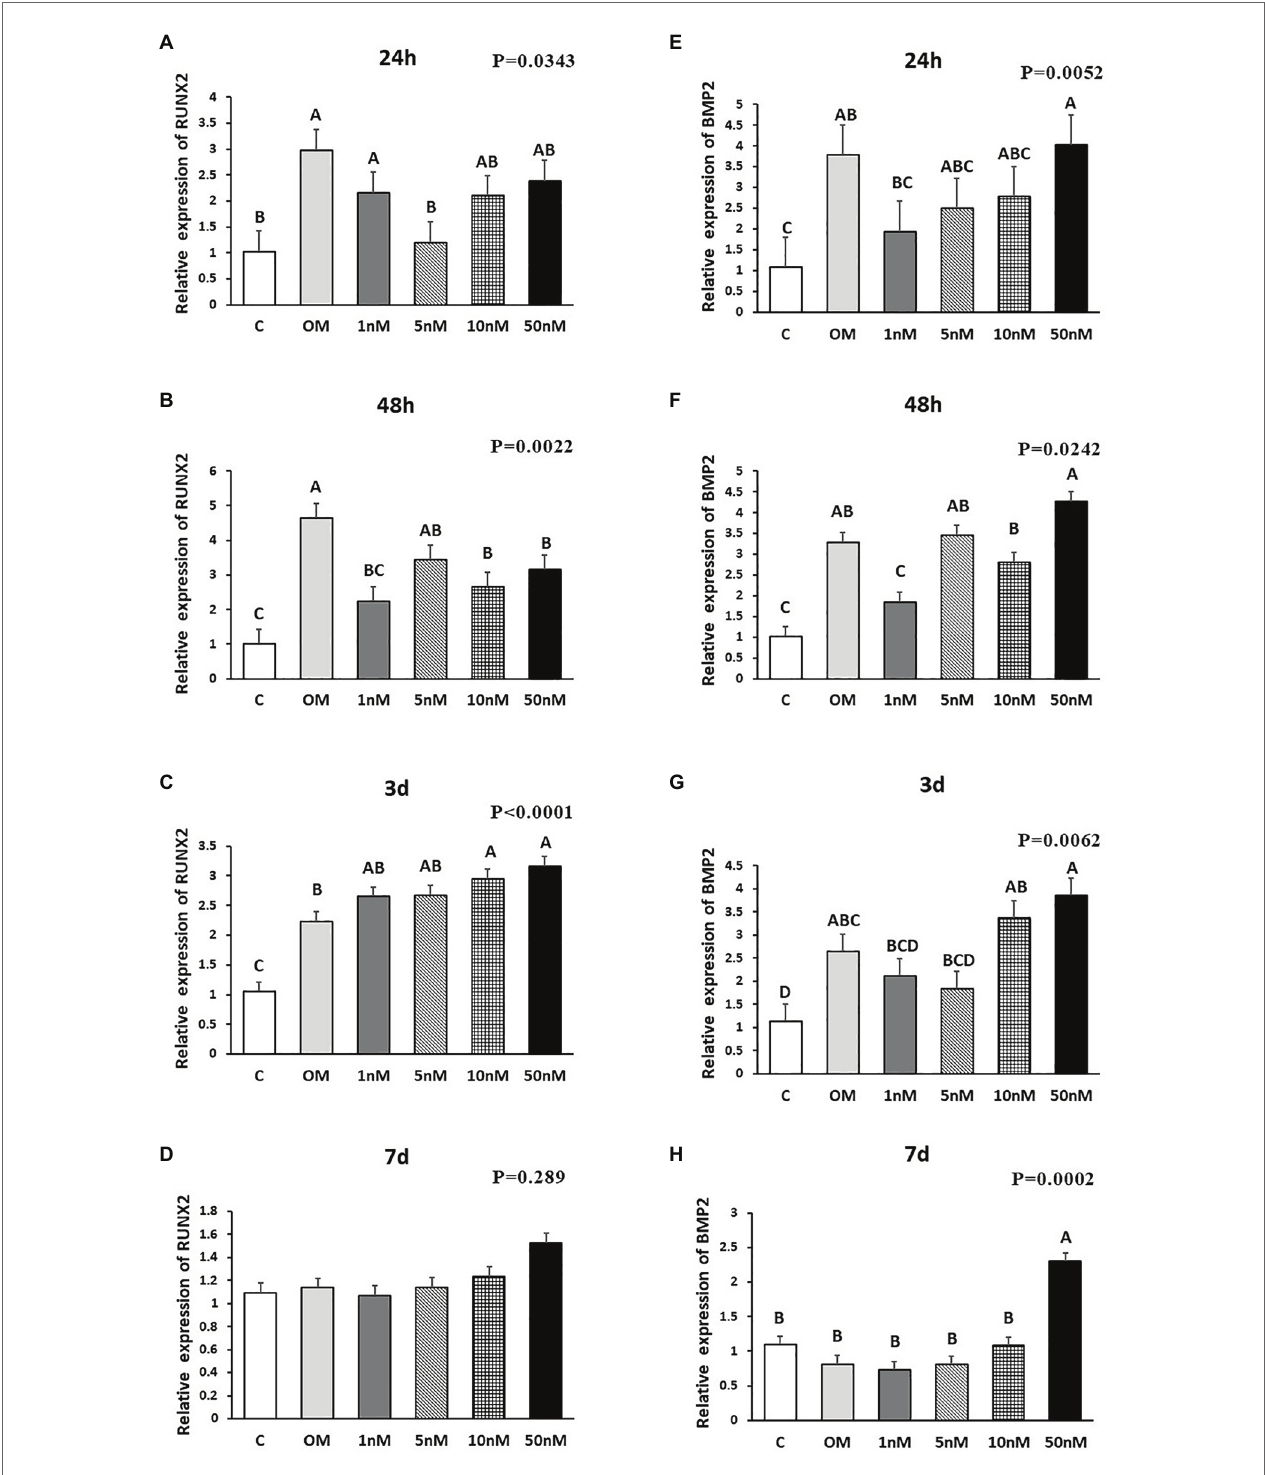
FIGURE 1 | Effects of 1,25-Dihydroxyvitamin D 3 (1,25OHD) on chicken osteoblasts runt related transcription factor 2 (RUNX2) and bone morphogenetic protein 2 (BMP2) gene expression by using quantitative Reverse Transcription PCR (qRT-PCR). Cells were treated with control media, osteogenesis media, or osteogenesis media with 1, 5, 10, or 50 nM 1,25OHD. (A–D) showed the messenger RNA (mRNA) expression of RUNX2 at 24 and 48 h and 3 and 7 days, respectively; (E–H) showed the mRNA expression of BMP2 at 24 and 48 h and 3 and 7 days, respectively. (A–D) Mean separation was indicated by different letters on the top of bars (Value means ± SEM, three